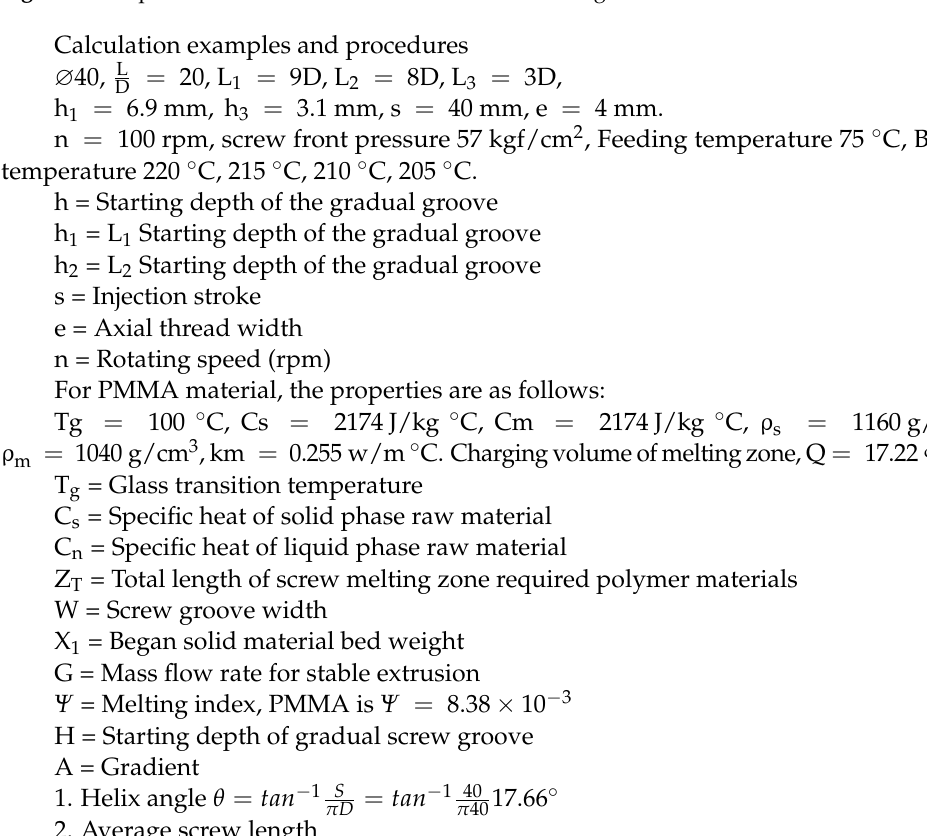
Figure 7. Temperature information for PMMA material design.